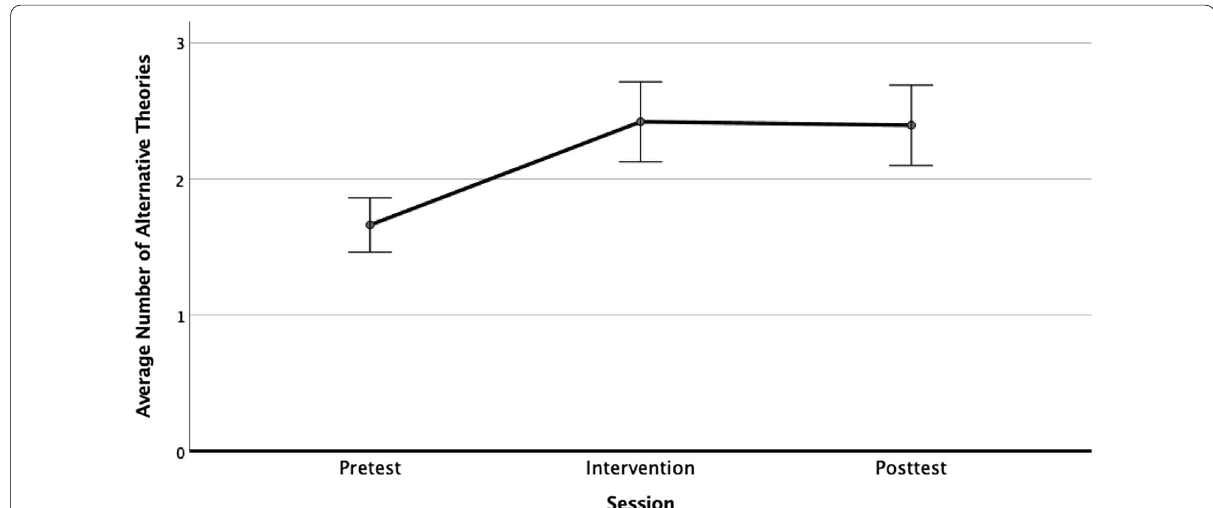
Fig. 3 Average number of alternative causal theories generated by students across sessions. Error bars represent within-subjects standard error of the mean (Cousineau,